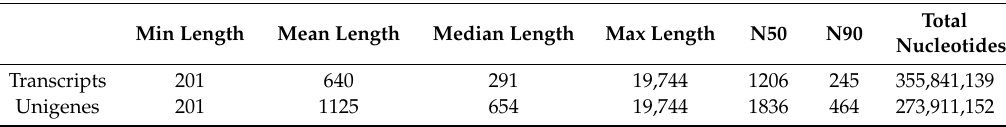
Table 2. Length distribution of the assembled transcripts and unigenes from the U. unicinctus larval transcriptome.